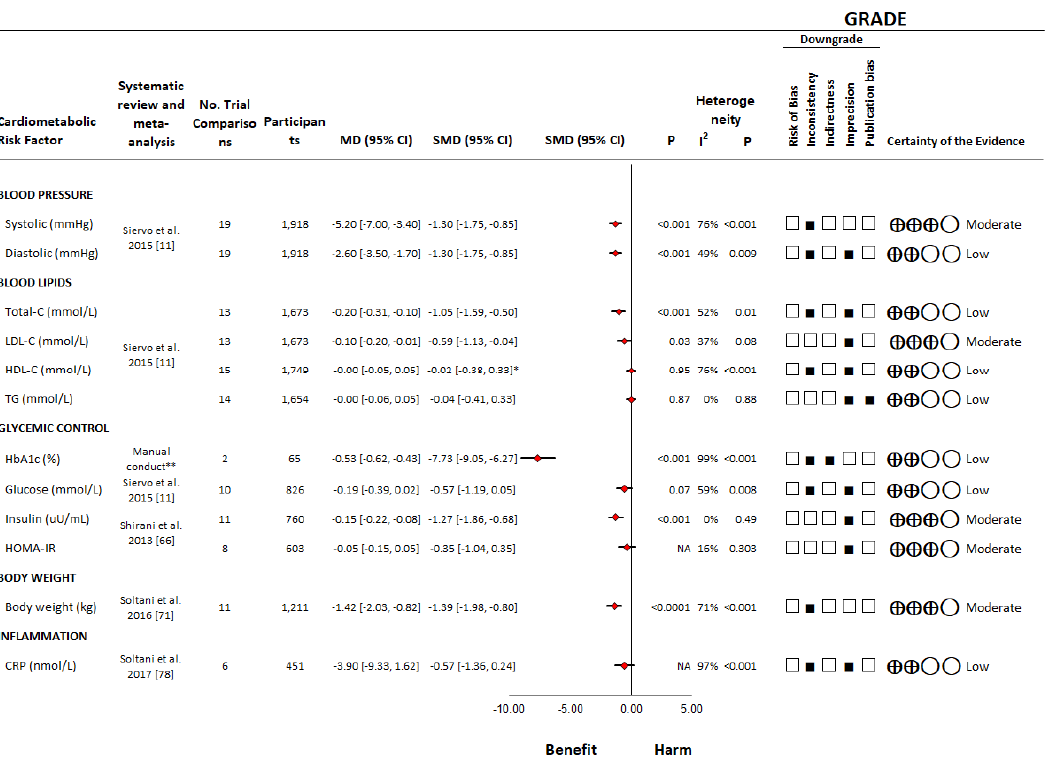
Figure 3. Summary plot of the effect of the DASH dietary pattern on cardiometabolic risk factors in controlled trials. Data are expressed as weighted mean differences with 95% CIs using random effects models in each systematic review and meta-analysis with the exception of HbA1c in which a fixed effects model was used due to the inclusion of <5 trials. To allow the pooled effect estimates for each end point to be displayed on the same axis, mean differences were transformed to standardized mean differences (SMDs). Pseudo-95% CIs for each transformed SMD were derived directly from the original mean difference and 95% CI. Between-study heterogeneity was assessed by the Cochran Q statistic, where P < 0.10 is considered statistically significant, and quantified by the I 2 statistic, where I 2 ≥ 50% is considered evidence of substantial heterogeneity [29]. The Grading of Recommendations, Assessment, Development and Evaluation (GRADE) of randomized controlled trials are rated as "High" certainty of evidence and can be downgraded by five domains. The filled black squares indicate downgrades for each outcome. *Due to the difference in directionality of HDL-C compared to the other outcomes with regards to signal for benefit or harm, the sign for the SMD was changed. ** Since no published systematic review and meta-analysis was retrieved from the search, we manually conducted a systematic review and meta-analysis on the DASH dietary pattern and HbA1c (Supplemental Tables S20–21 and Supplemental Figure S3). To convert Total-C, LDL-C, and HDL-C to mg/dL, multiply by 38.67; to convert TG to mg/dL, multiply by 88.57; to convert blood glucose to mg/dL, multiply by 18.02; to convert CRP to mg/L, multiply by 0.105. CI = confidence interval; CRP = C-reactive protein; GRADE = Grading of Recommendations, Assessment, Development and Evaluation; HbA1c = hemoglobin A1c; HDL-C = high-density lipoprotein-cholesterol; HOMA-IR = Homeostatic Model Assessment of Insulin Resistance; LDL-C = low-density lipoprotein-cholesterol; MD = mean difference; NA = not available; SMD=standardized mean difference; TG = triglycerides; Total-C =